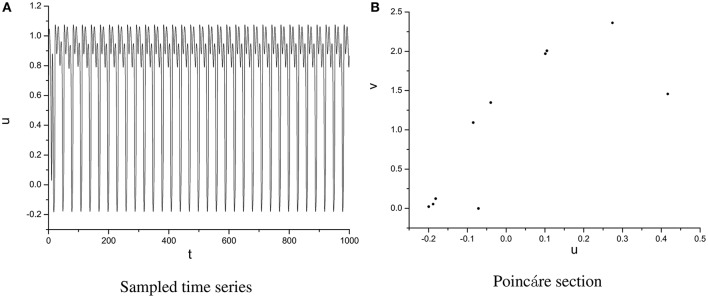
Sampled time series (A) and its Poincáre section (B) as ω = 0.618.